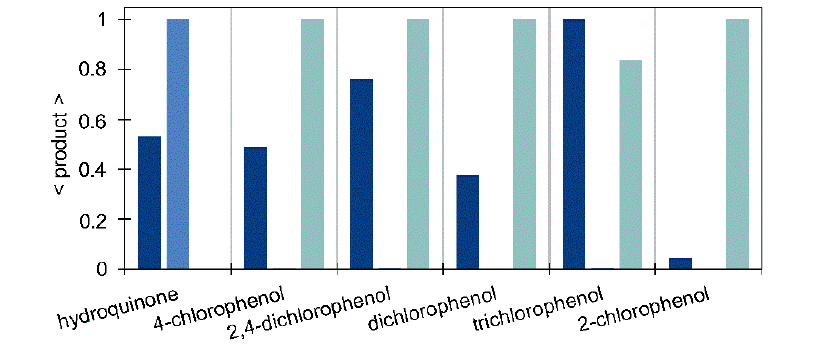
Figure 8. Relative amount of aromatic products (see Equation (4) in Section 2.4) in electrooxidized samples PHN determined by SPME/GC–MS (normalized for each product to the highest peak area of the three analyzed samples).